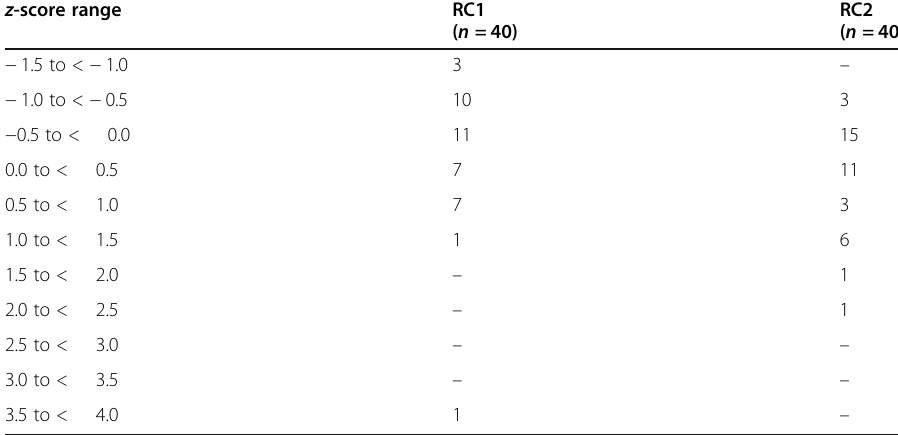
Table 6 The results of referential cohesion analysis z -score